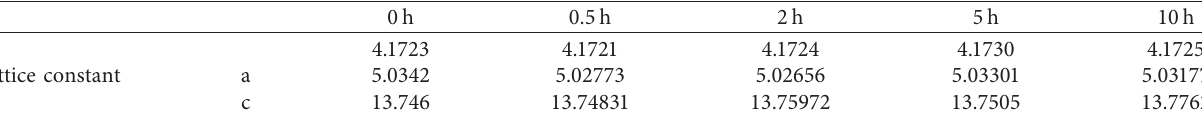
Figure 5: The measured volume fraction plotted against the ball-milling time. Table 2: The average lattice constant of NiO in the milled